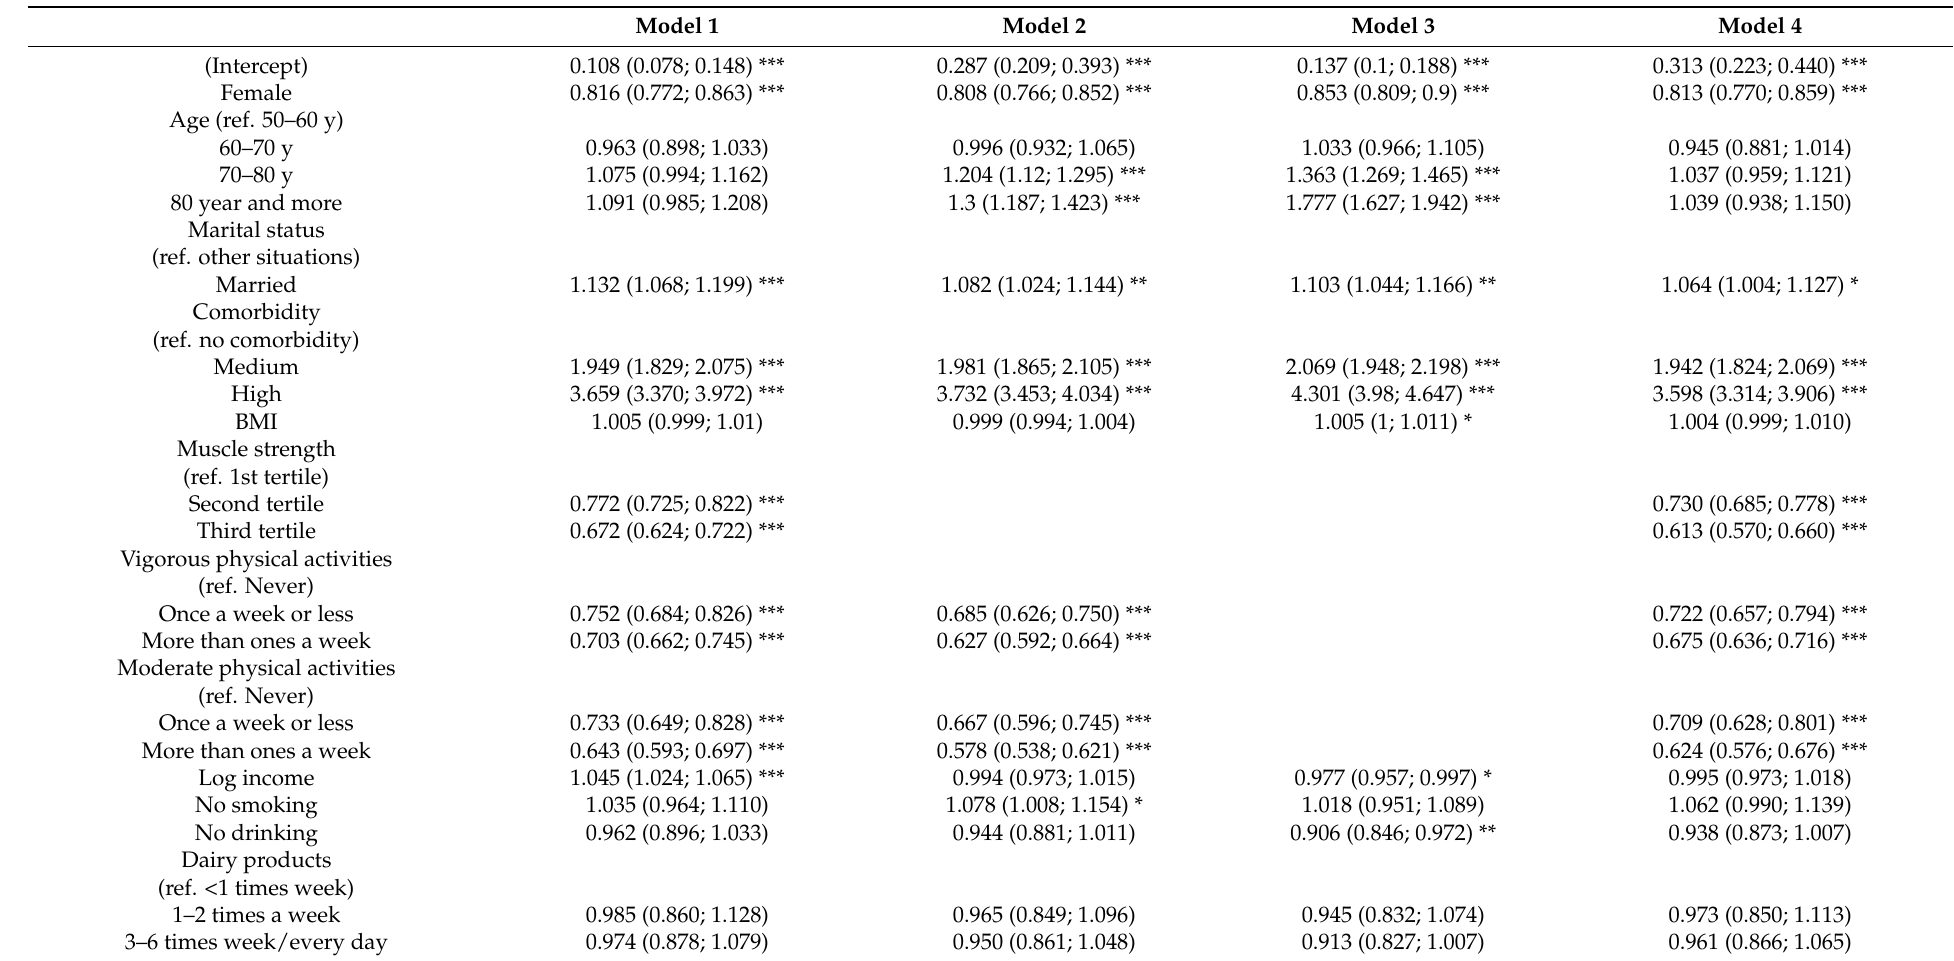
Table 2. Panel Estimators of hospitalization for Generalized Linear Models with logit